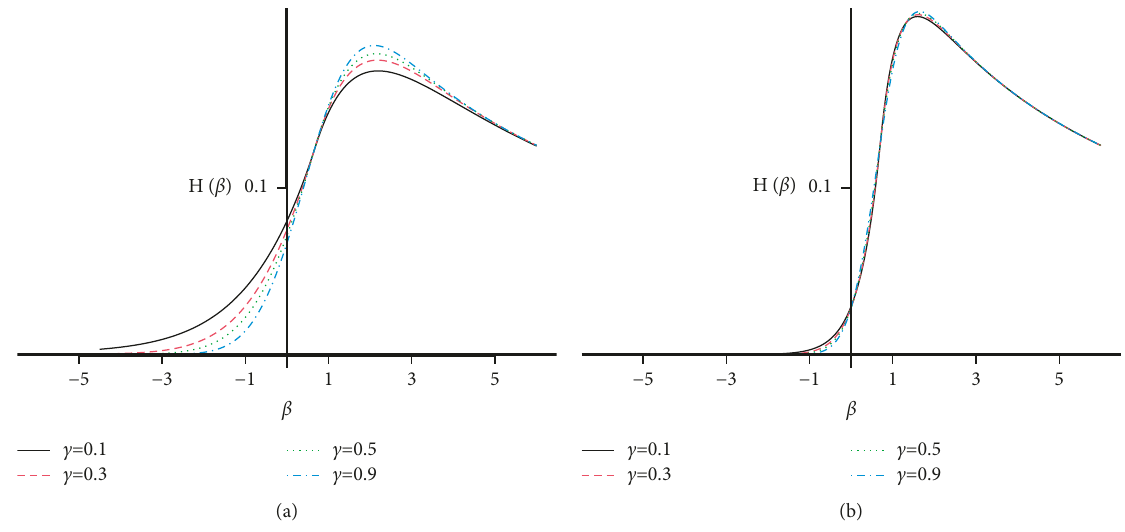
Figure 4: Plots the hazard rate function of SElastic-net ( ζ , c ) with different values of c and; ζ � 1 (a), ζ � 3